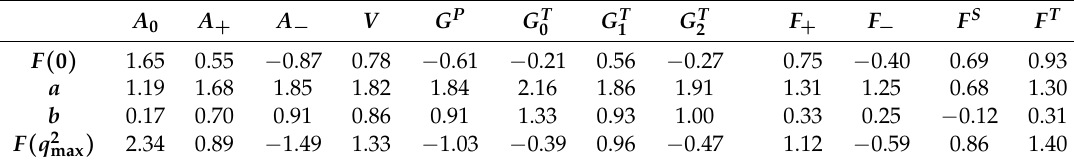
Table 2. Parameters of the dipole approximation in Equation (37) for B c → J / ψ ( η c ) form factors. Zero-recoil values of the form factors are also